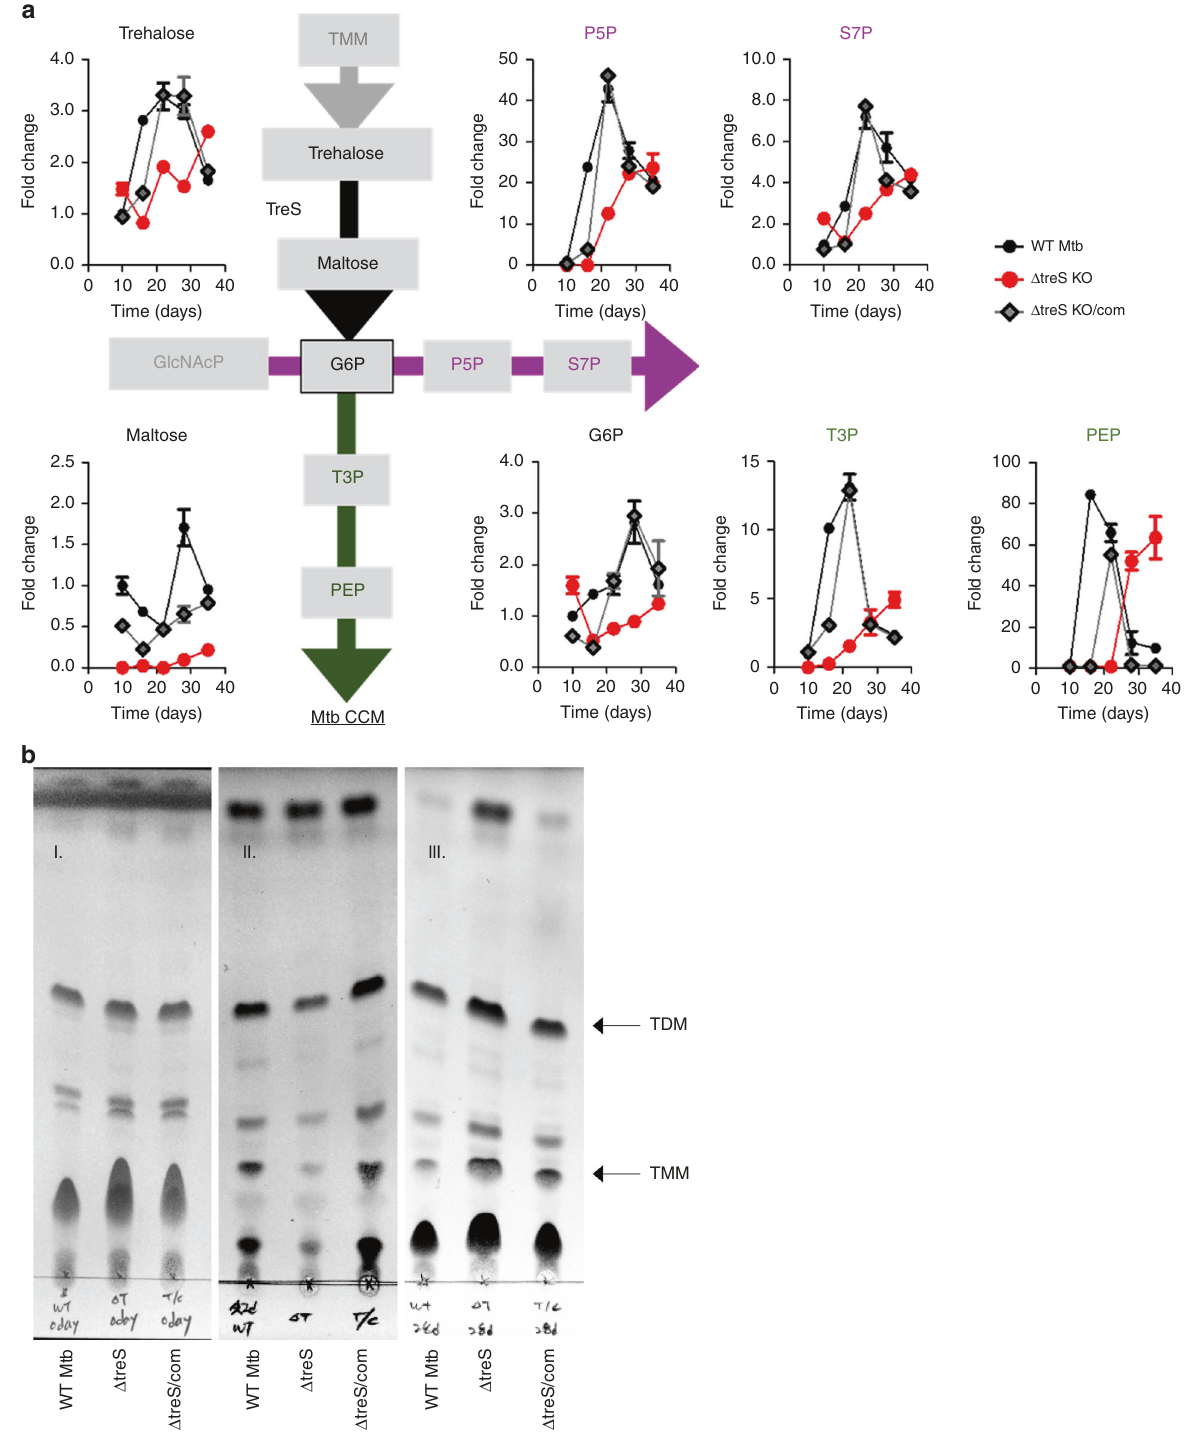
Fig. 2 Metabolic consequences of TreS de fi ciency on PLB metabolism. a Time-course kinetics of pool sizes of glycolysis (green font/line), the pentose phosphate pathway (magenta font/line), and sucrose metabolism (black font/line) intermediates of WT Mtb, Δ treS, and Δ treS/com of mycobacterial bio fi lm culture. P5P, pentose 5-phosphates; S7P, sedoheptulose 7-phosphates; G6P, glucose 6-phosphates; T3P, triose 3-phosphates (dihydroxyacetone phosphate and glyceraldehyde phosphate); PEP, phosphoenolpyruvate. b Time course of extractable TMM/TDM from WT Mtb, Δ treS, and Δ treS/com harvested during the replicating state ( I ), day 22 ( II ), and day 28 ( III ) of mycobacterial bio fi lm culture. TMM/TDM extraction and TLC development